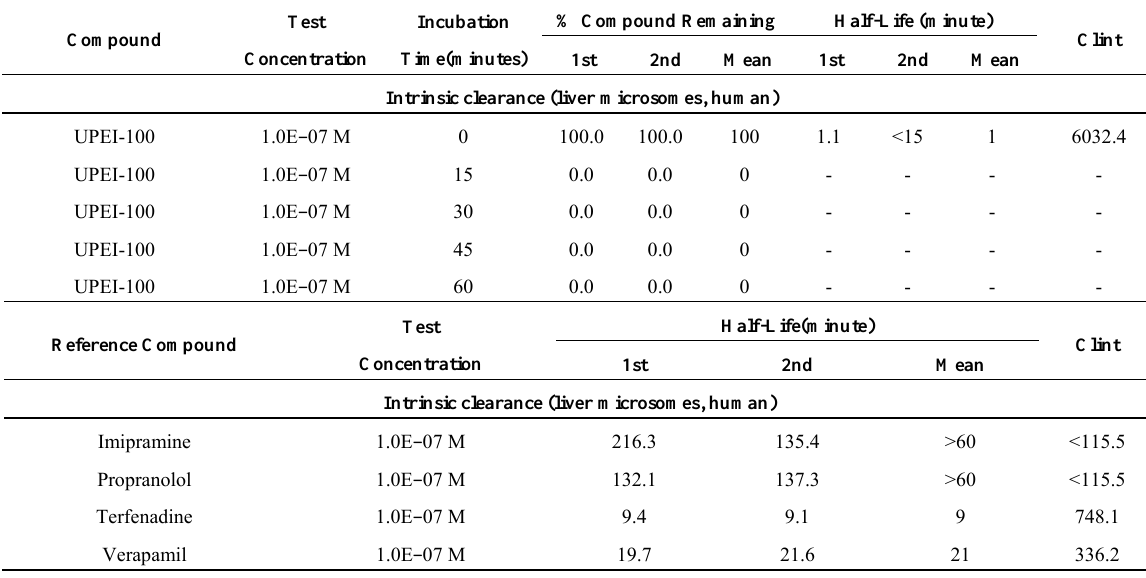
Table 4. Metabolic stability/intrinsic clearance (Cl int ) of UPEI-100 in human liver